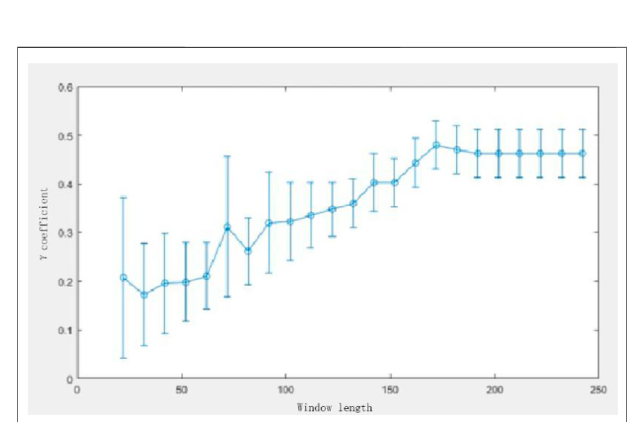
FIGURE 7 | Illustration of the coef fi cient γ vs. W